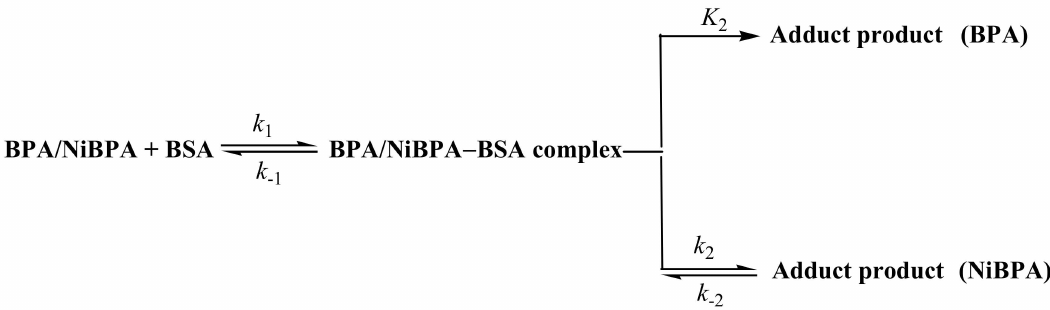
Scheme 1. Reaction scheme for the binding of BSA to both BPA and NiBPA